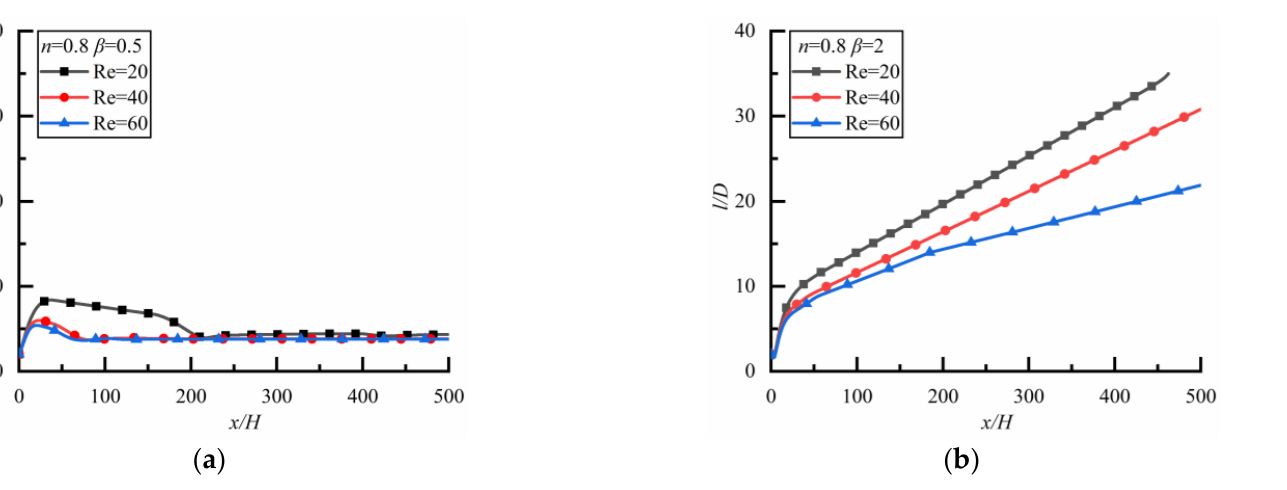
Figure 9. Changes of l/D along flow direction for different Re ( n =1). ( a ) β =0.5, ( b ) β =2.